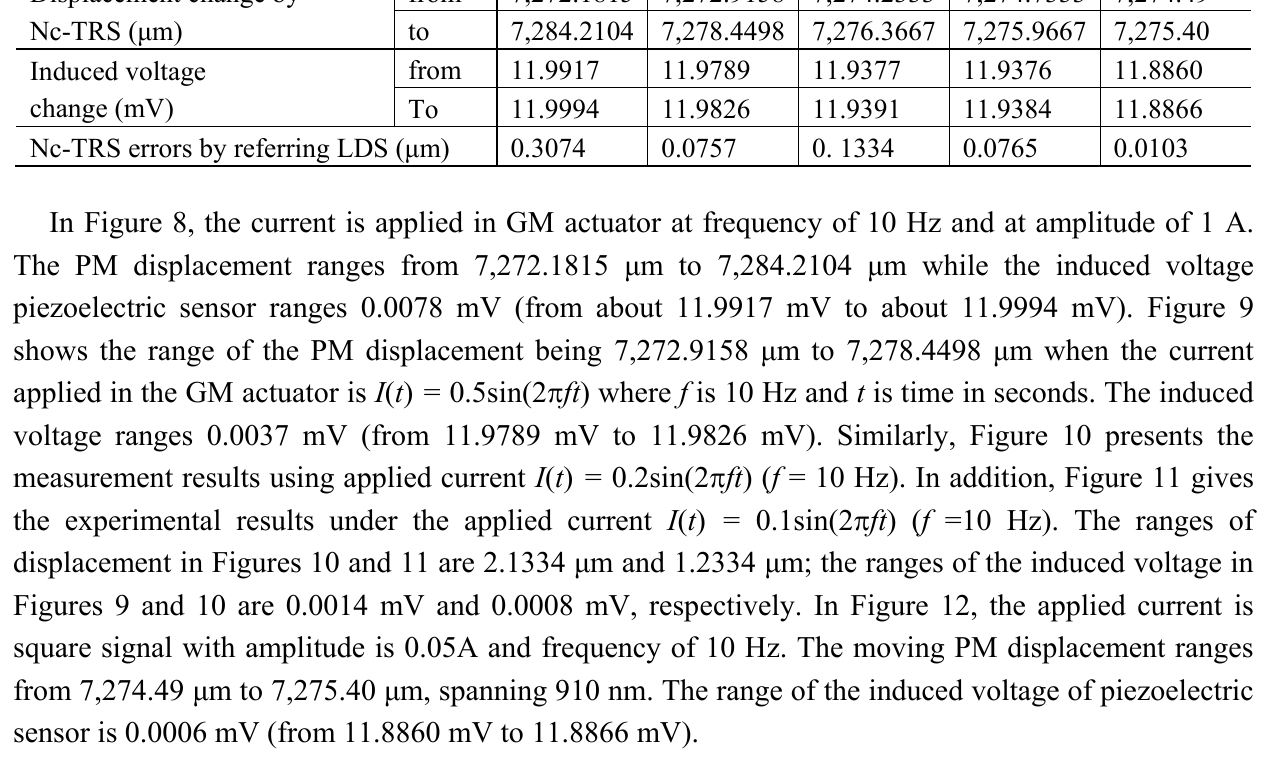
Figure 8. The sensing effect under applied current I ( t ) = sin(2  ft ) A ( f = 10